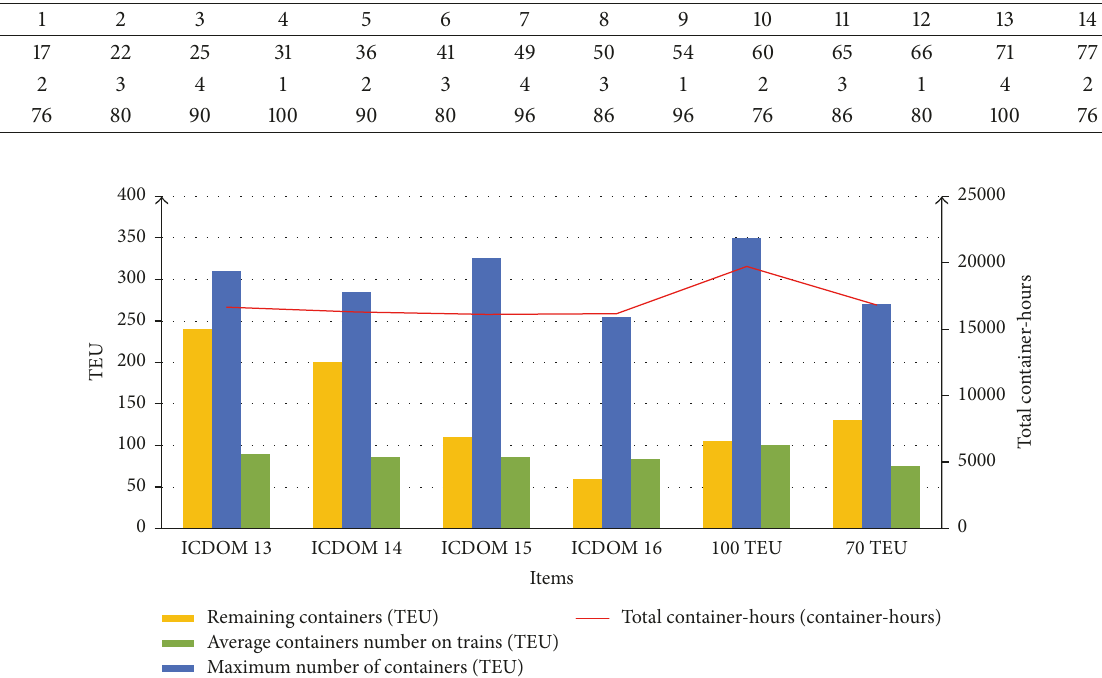
Figure 6: Evaluation results of container trains produced by the ICDOM and